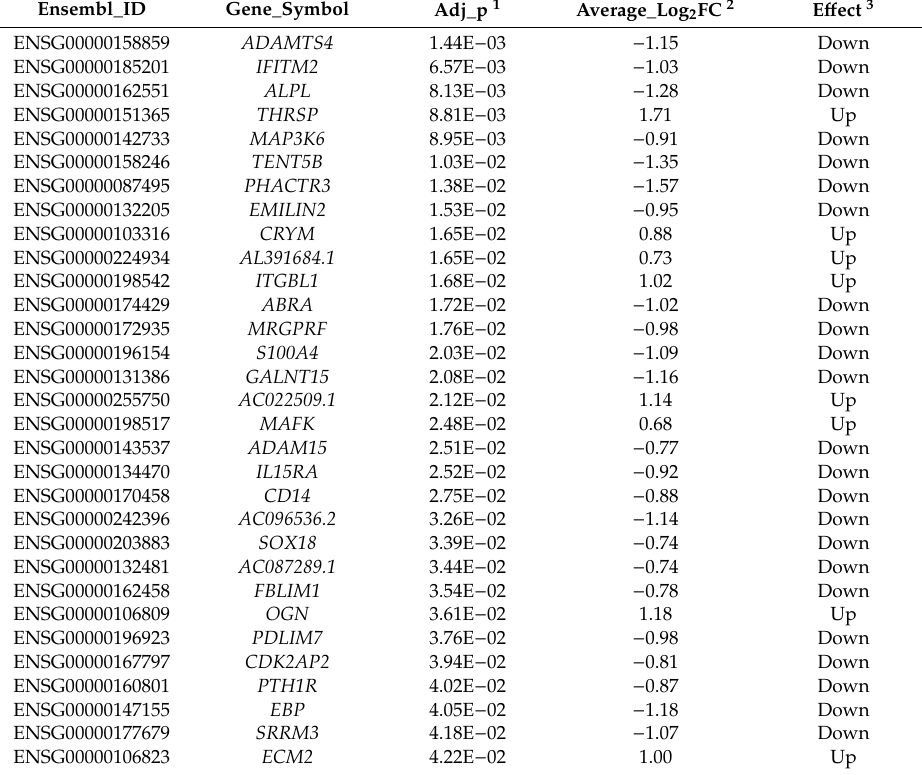
Figure 2. Venn diagram showing the number of di ff erential expressed genes from individual studies and meta-analysis. Table 3. Di ff erential expressed genes newly identified in the meta-analysis of DCM vs. NF.